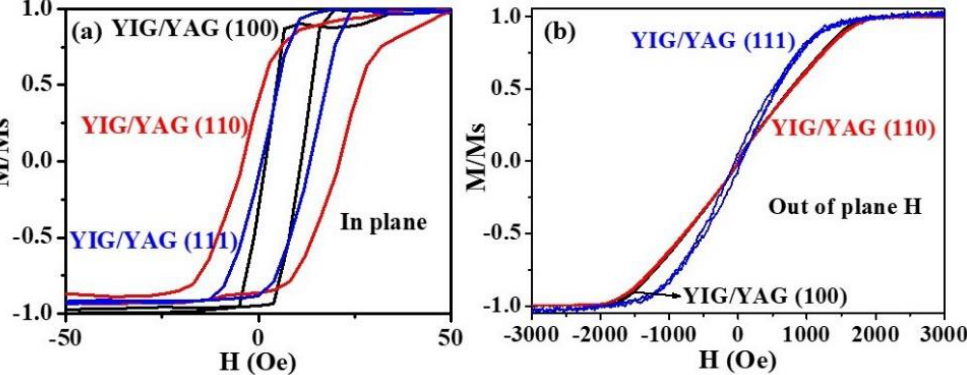
Figure 4. ( a – c ) MFM phase images showing the stripe domains in the thickest YIG films on (100), (110), and (111) YAG substrates.